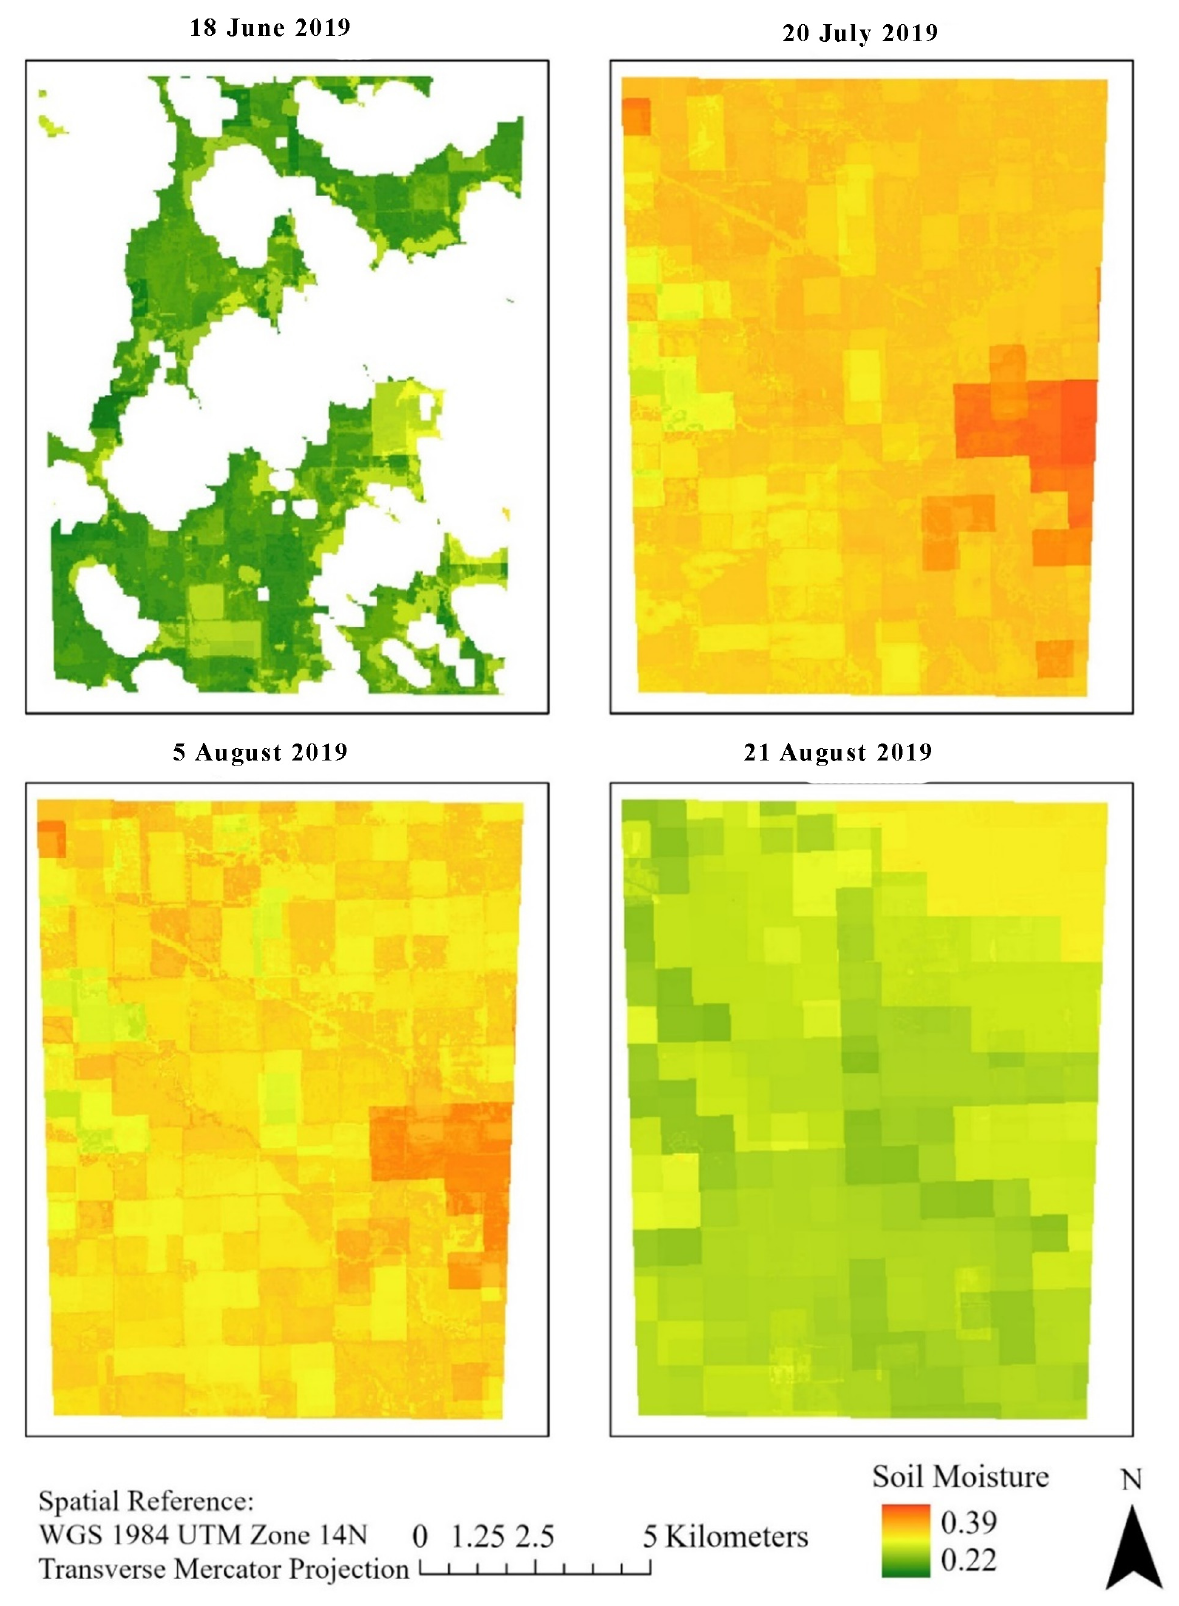
Figure 12. Predicted surface SM (m 3 m − 3 ) for four days (18 June, 20 July, 5 August, and 21 August) over the selected agriculture field in Cass County within the study area.